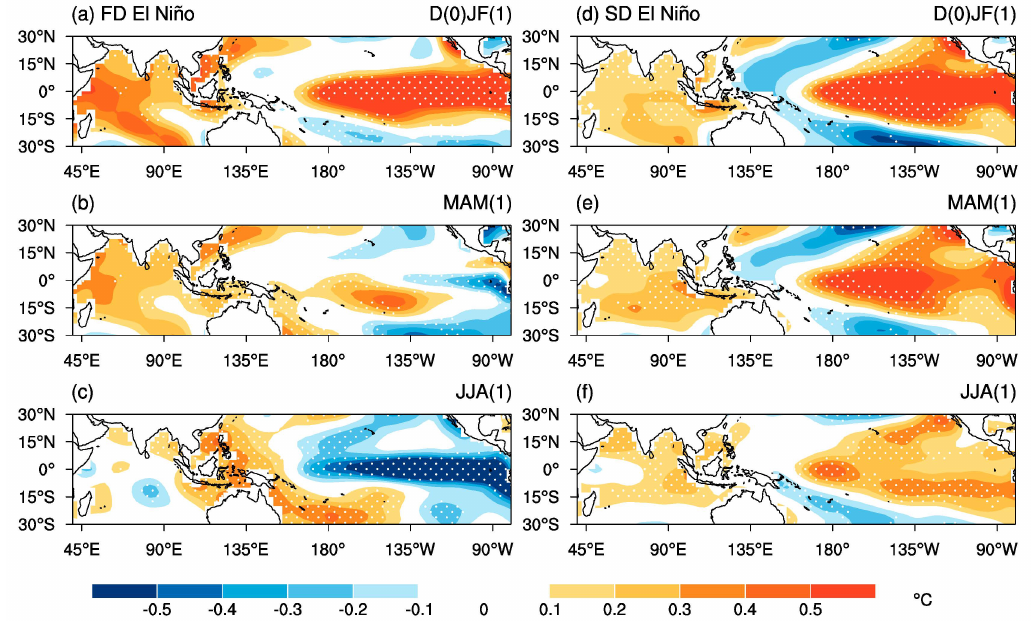
Figure 1. Composite SST anomalies of FD El Niños from ( a ) December–January–February (D(0)JF(1)) to ( c ) June–July– August (JJA(1)). ( d – f ) As in ( a – c ), but for SD El Niños. White dots indicate where the significance exceeds the 90% confidence